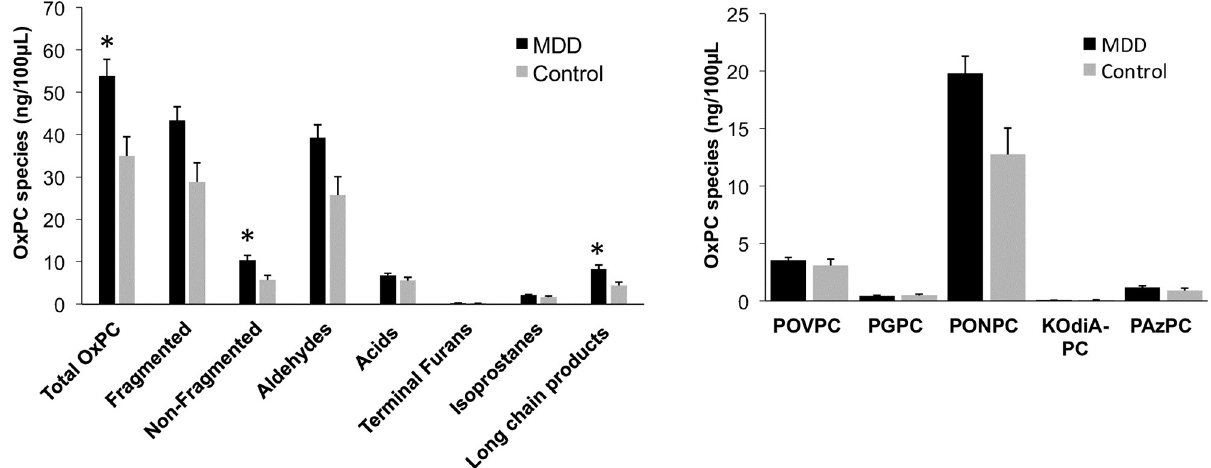
Fig 3. Baseline OxPC levels divided into total OxPCs with subgroups [A] and 5 specific OxPC compounds [B] compared between MDD subjects [n = 38] and controls [n = 9]. Values are mean ± SEM. � = p < 0.05.